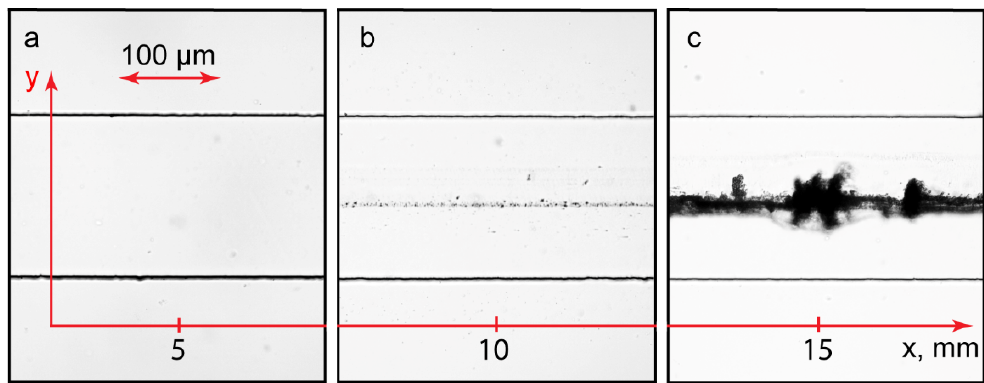
Figure 7. PAA ‐ CTAB complexation reaction in a Ψ‐ type microfluidic chip (L = 15 mm and W = 200 μ m). Distance from the junction of inputs, mm: 5 ( a ), 10 ( b ), and 15 ( c ). All the input flow rates are 10 μ L/min. Duration of the experiment: 15 min.